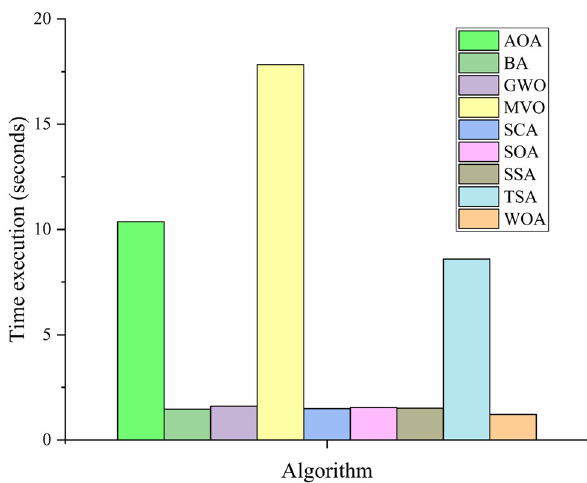
Fig. 20 The time execution of the algorithms for case 2